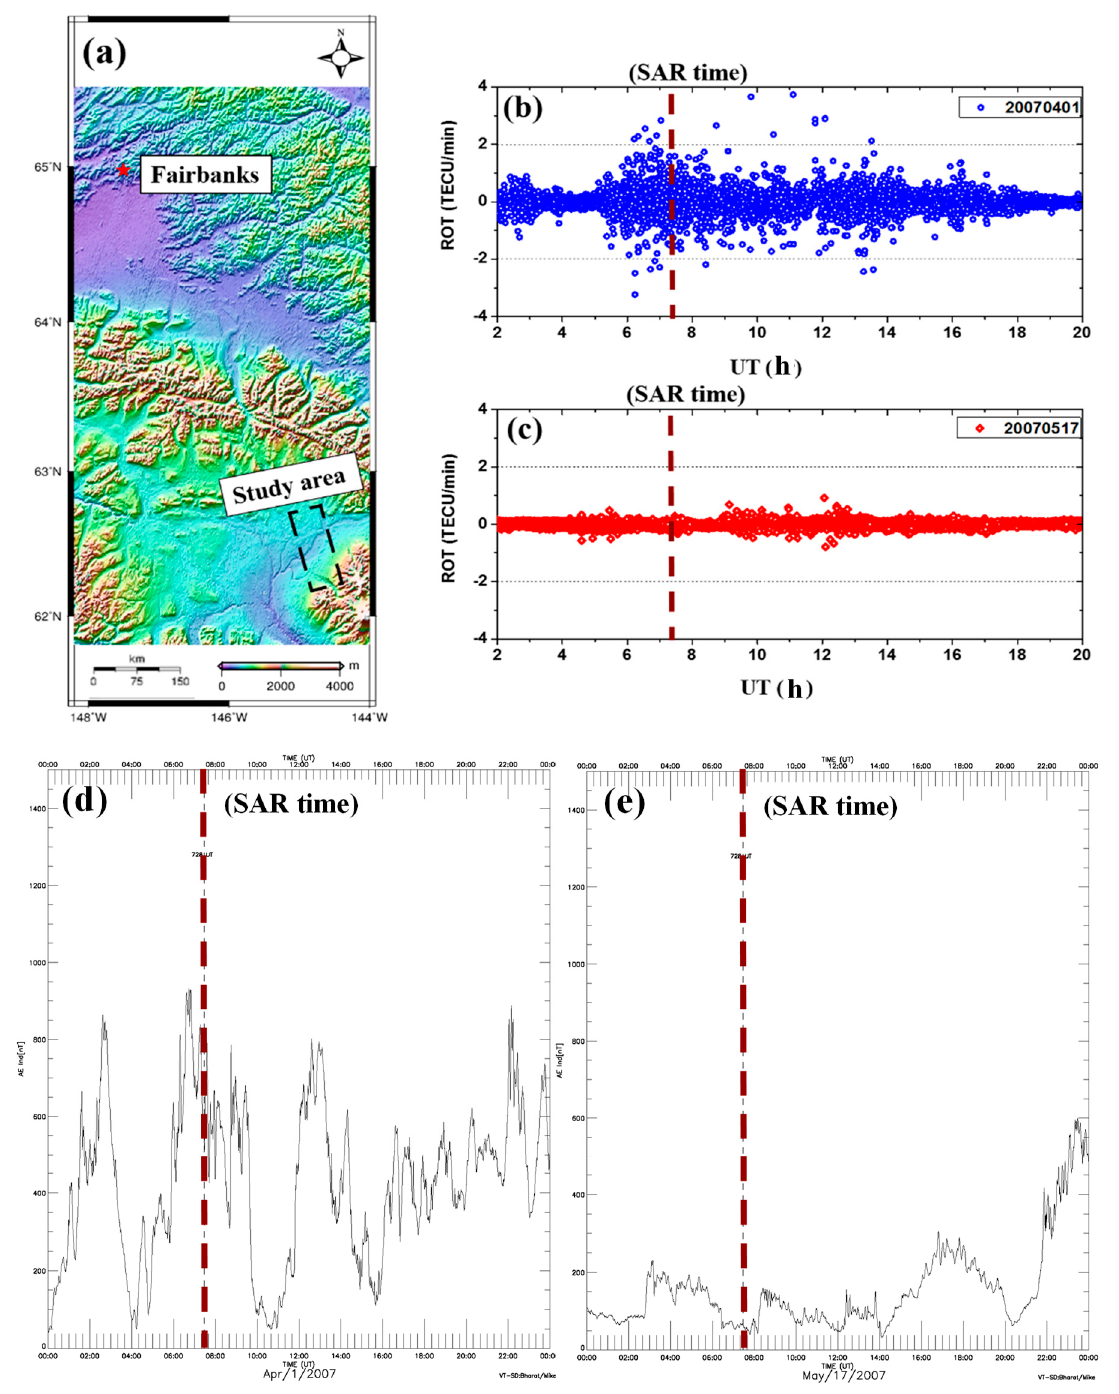
Figure 2. Experimental region and Global Positioning System (GPS)-measured ionospheric variations at Synthetic aperture radar (SAR) acquisition time. ( a ) Experimental area. The black rectangle denotes the spatial coverage of SAR images and red pentagram shows the location of a dual-frequency GPS station, ( b , c ) GPS-measured the time rate of changes of total electronic content(ROT) values on 1 April and 17 May 2007, respectively, ( d , e ) AE variations on April and May 2007, respectively.